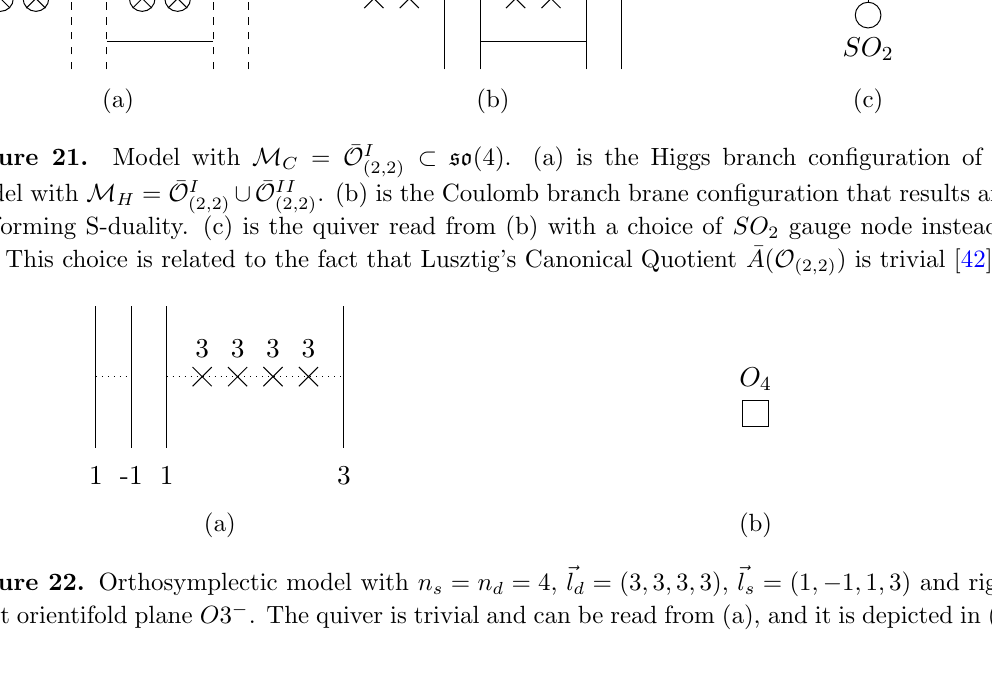
The Coulomb branch brane con(cid:12)guration and quiver are depicted in (cid:12)gure 22. We say that the Higgs branch corresponds to the closure of the trivial orbit, i.e. a single